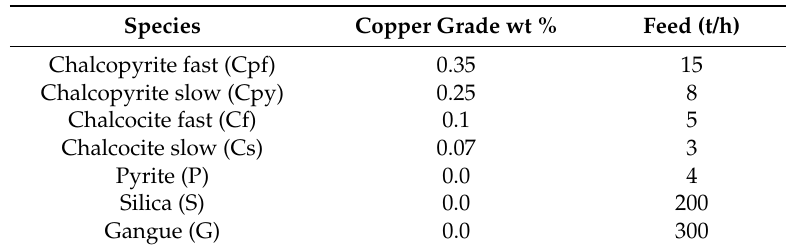
Table 1. Species in feed to process.